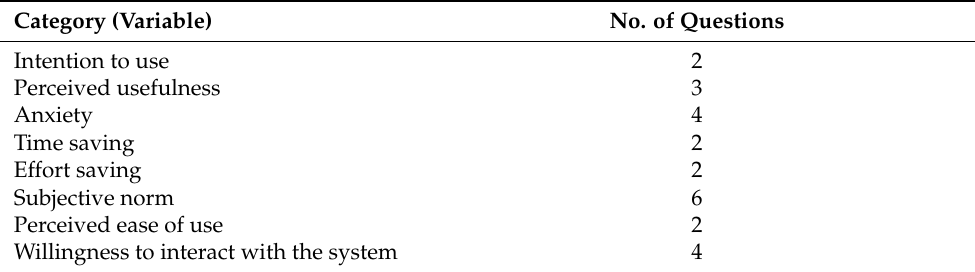
Table 2. Number of questions in each category of the